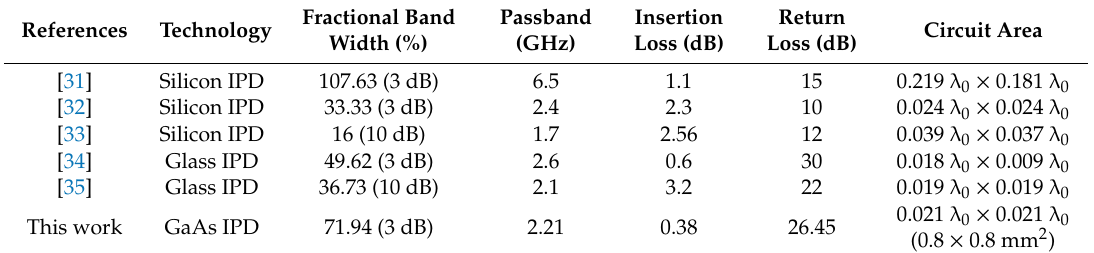
Table 2. Performance comparison of proposed BPF and published BPFs.